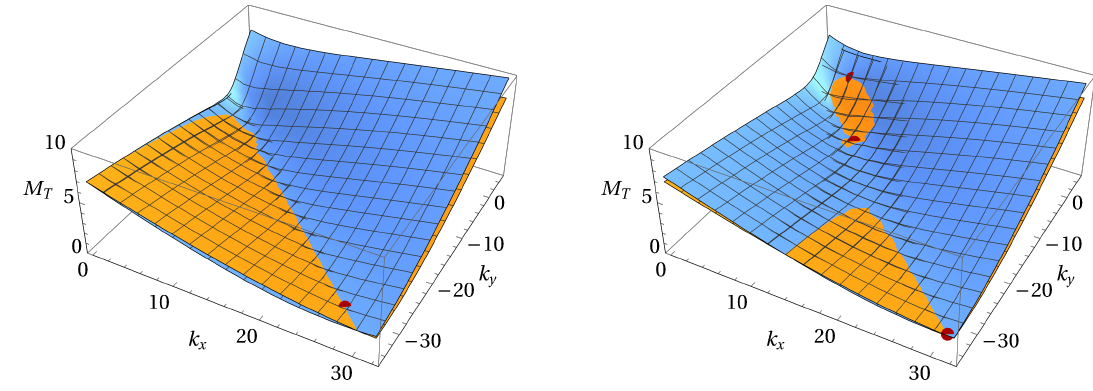
Figure 3 . Transverse masses M 1 T and M 2 T for an event with vanishing (left) and nonvanishing upstream momentum (right). The red points in each plot correspond to the solutions to the reduced rank condition of the algebraic singularity method. The scales of axes are arbitrarily